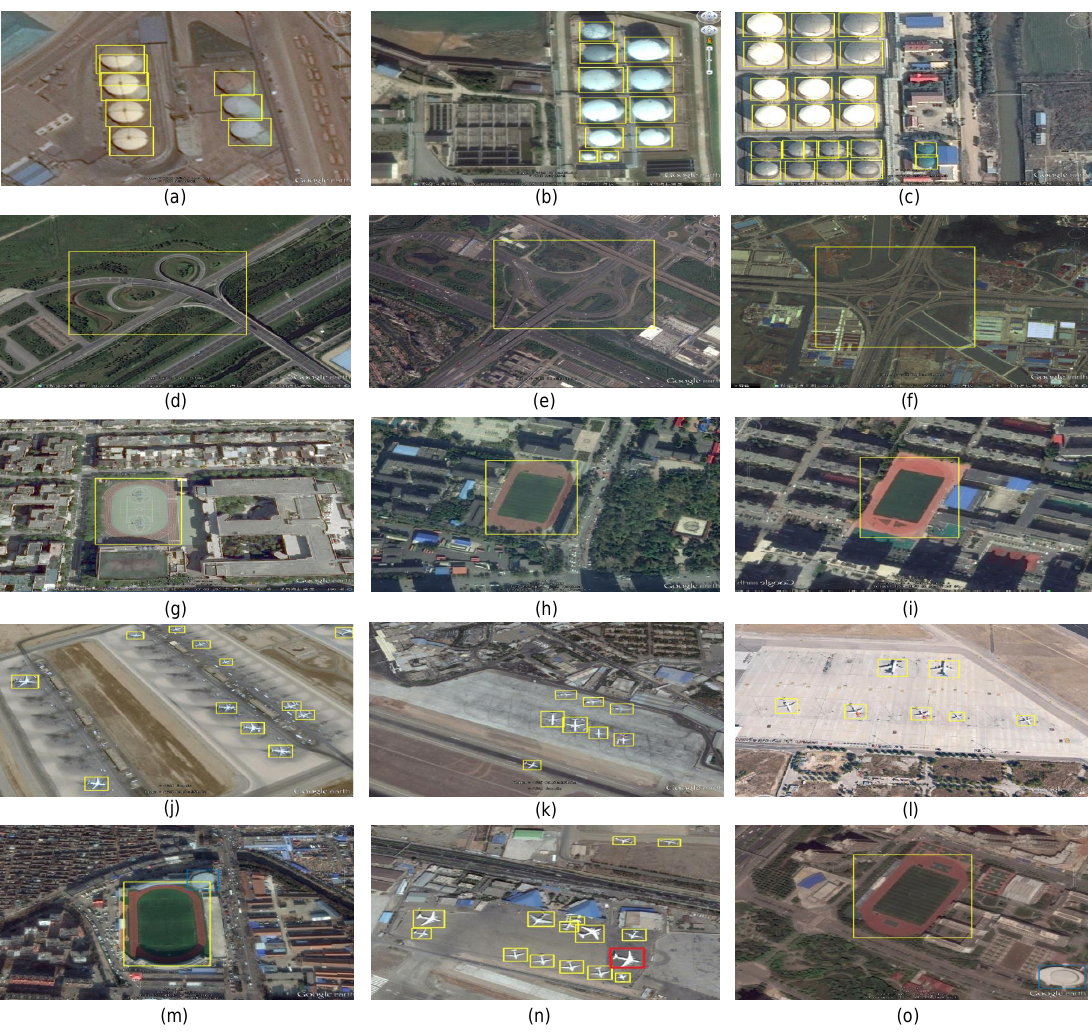
Figure 9. Some object detection results from RSOD dataset. Yellow, red, and blue colors represent true positive, false negative, and false positive cases, respectively. ( a – c ) show examples of true positive detection of oil tank, ( d – f ) show examples of true positive detection of overpass, ( g – i ) show examples of true positive detection of playground, ( j – l ) show examples of true positive detection of aircraft, and ( m – o ) show examples of false positive and false negative